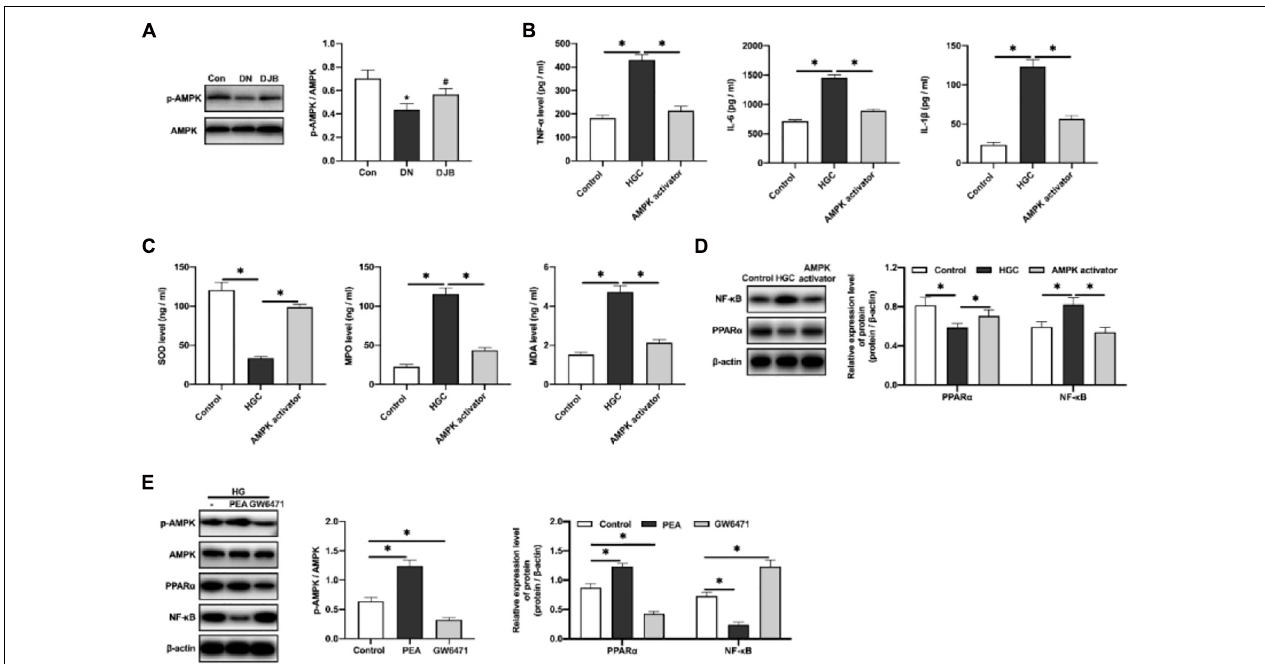
FIGURE 5 | AMPK α inhibited the inflammatory responses in the high-glucose-cultured HK-2 cells by activating PPAR α and downregulating NF- κ B. (A) Adenosine 5 (cid:48) -monophosphate (AMP)-activated protein kinase (AMPK) and phosphorylated AMPK detected by Western blotting in rat renal tissues. Levels of the inflammatory factors (B) and oxidation-related factors (C) in the cell culture supernatants were quantified by ELISA. (D) Expression levels of PPAR α and NF- κ B in HK-2 cells detected by Western blotting. (E) Protein expression detected by Western blotting. All data represented the mean ± SD. ∗ p < 0.05 [compared with the control (Con) group]; # p < 0.05 [compared with the diabetic nephropathy (DN)